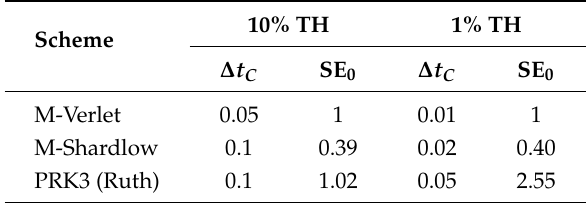
Table 2. Scaled-efficiency for the M-Verlet, M-Shardlow, and PRK3 (Ruth) schemes. The efficiencies are normalized by the one for the M-Verlet scheme. (TH: